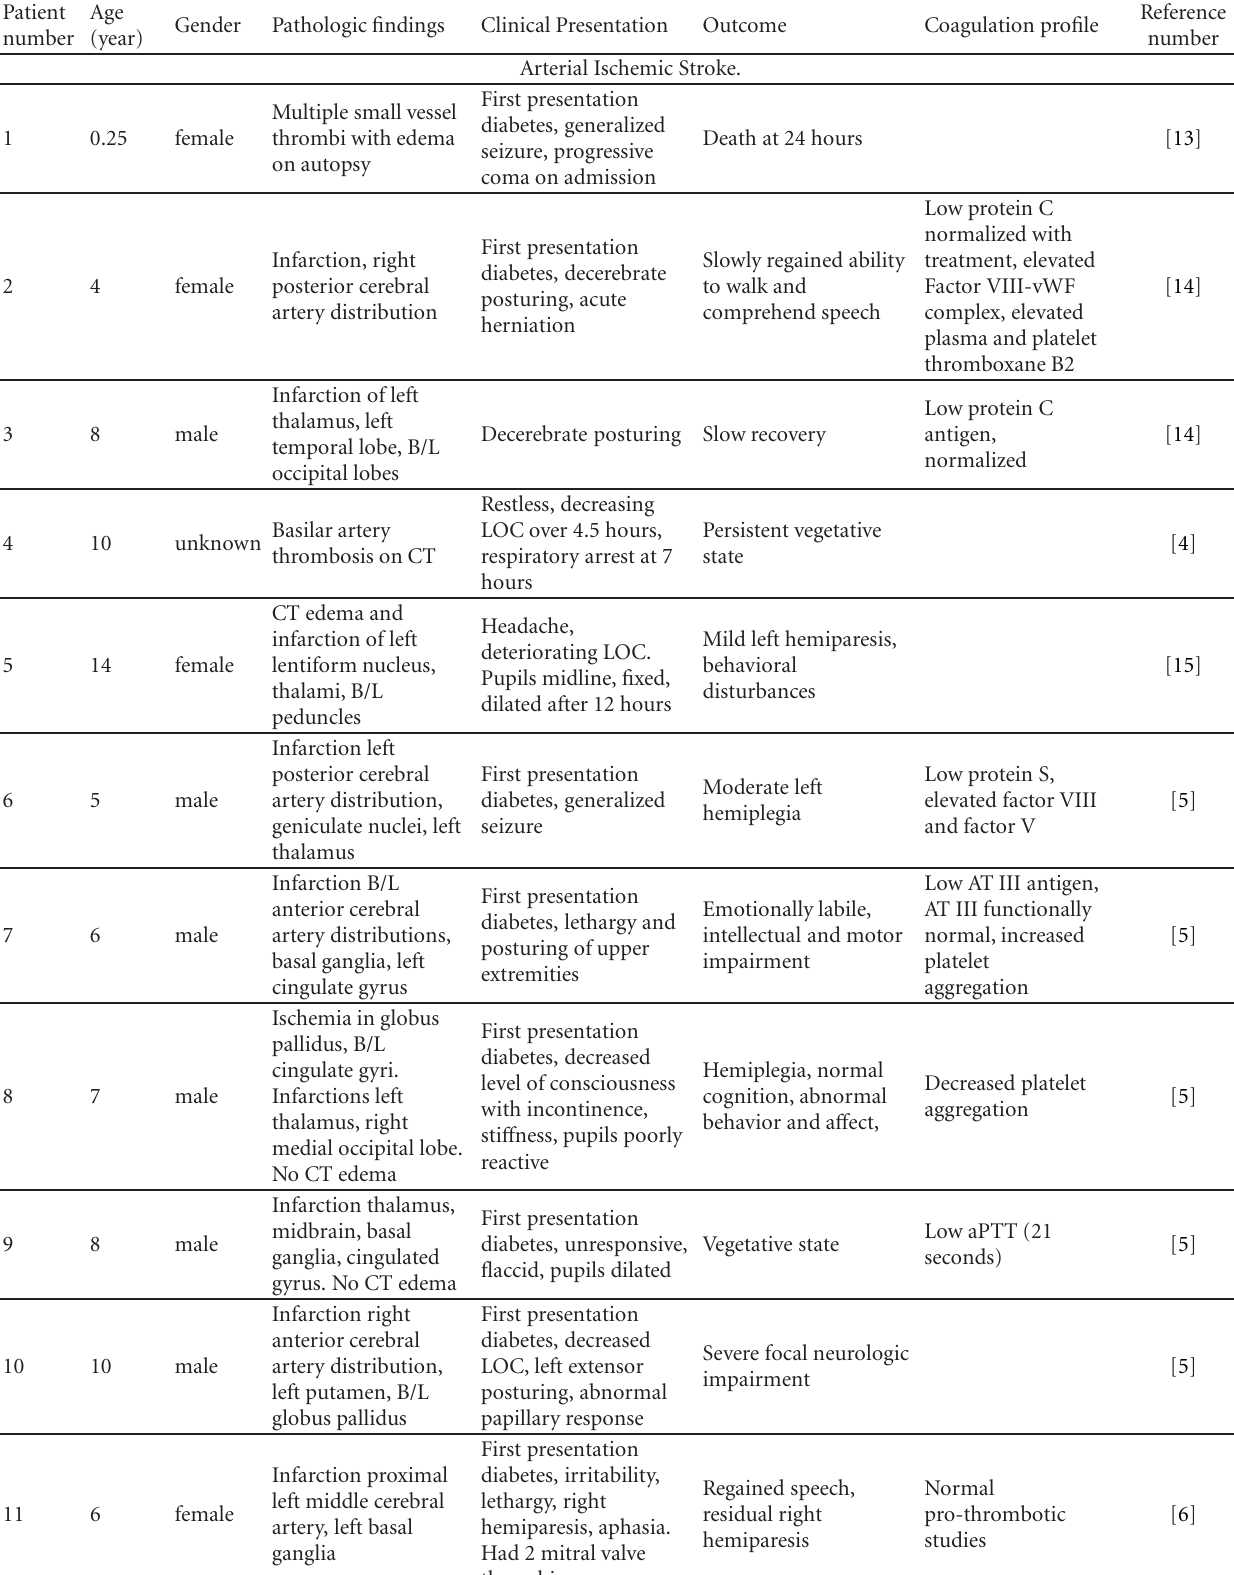
Table 1: Case reports of arterial ischemic stroke, cerebral venous thrombotic stroke, and hemorrhagic stroke associated with an episode of DKA in children and